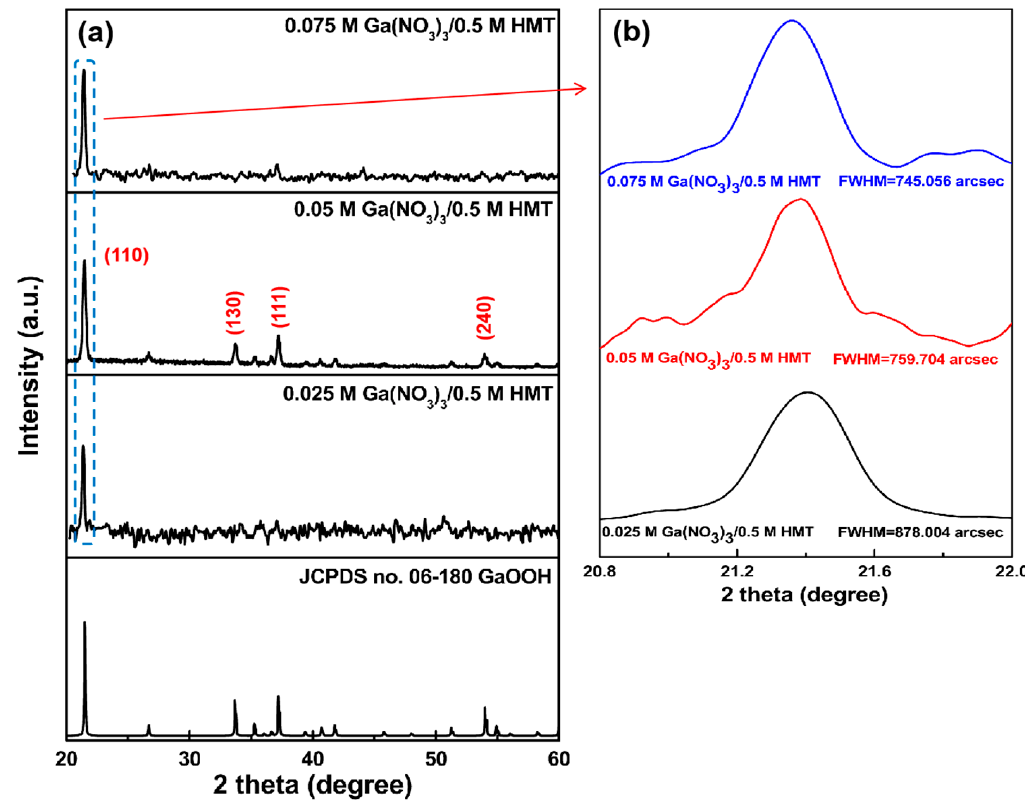
Figure 2. ( a ) XRD patterns of as-prepared GaOOH nanorods obtained from Ga(NO 3 ) 3 at concentrations of 0.025 M, 0.05 M, and 0.075 M. ( b ) FWHMs of the GaOOH (110) crystal plane diffraction peaks shown in ( a ).